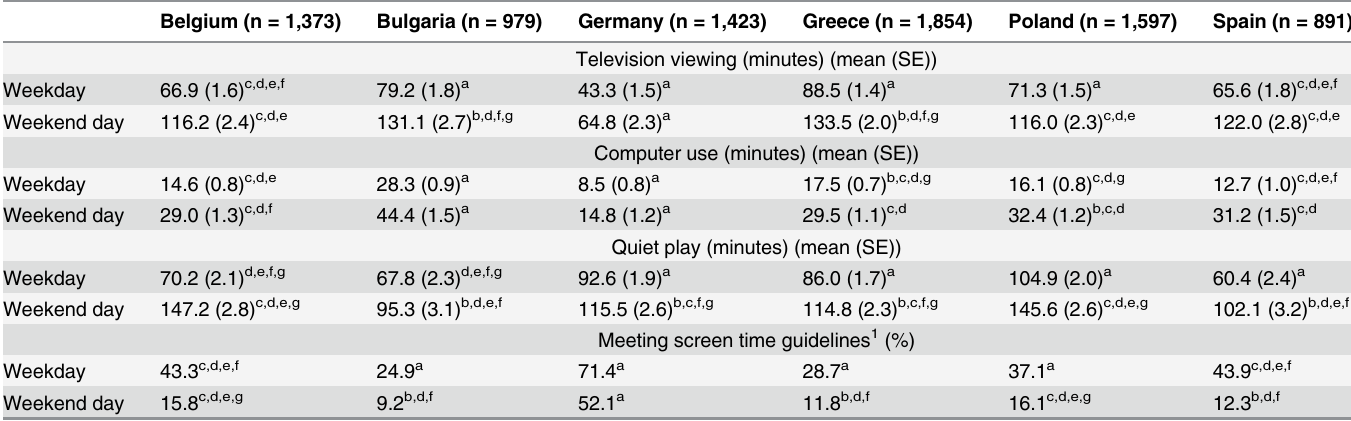
Table 5. Levels of sedentary behaviour in preschool children from six European countries (n = 8,117) (adjusted for sex and